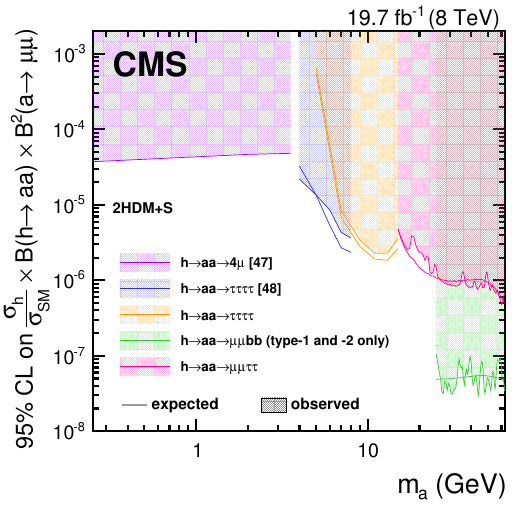
Figure 7 . Expected and observed 95% CL exclusion limits on ( (cid:27) h =(cid:27) SM ) B (h ! aa) B 2 (a ! (cid:22) + (cid:22) (cid:0) ) for various exotic h boson decay searches performed with data collected at 8 TeV with the CMS detector, assuming that the branching fractions of the pseudoscalar boson to muons, (cid:28) leptons and b quarks follow eqs. (1.1){(1.2). This assumption implies that the limit shown for h ! aa ! 2 (cid:22) 2b is valid only in type-1 and -2